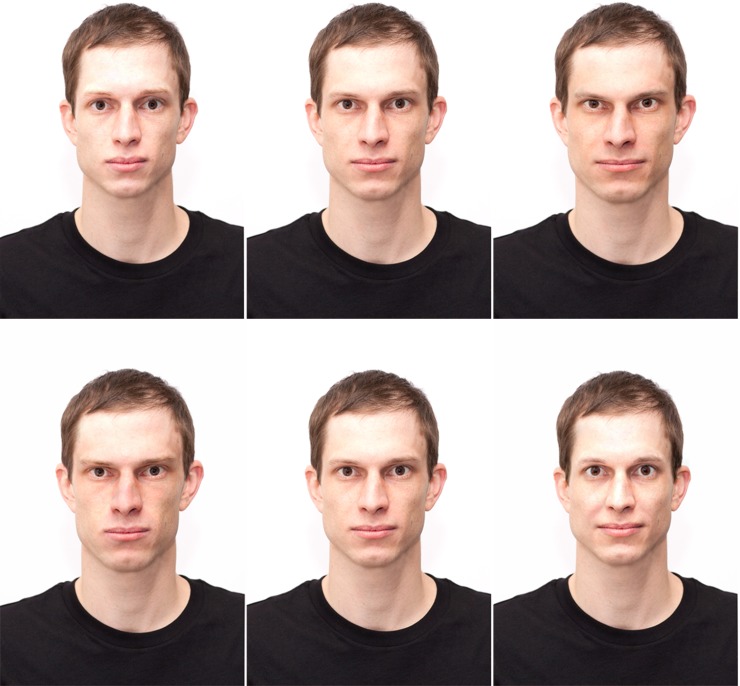
An original face (middle) and versions with a reduced (left) and an enhanced value (right) on agency (top) and communion (bottom).